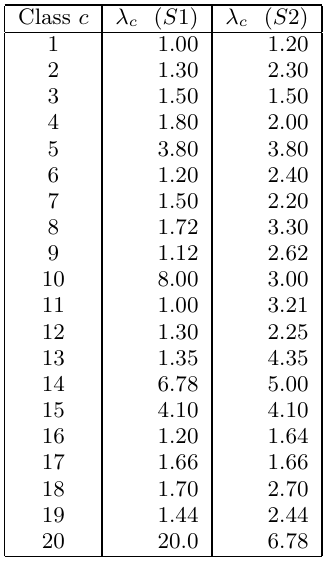
Table 1: Arrival rates for scenarios S1 and S2